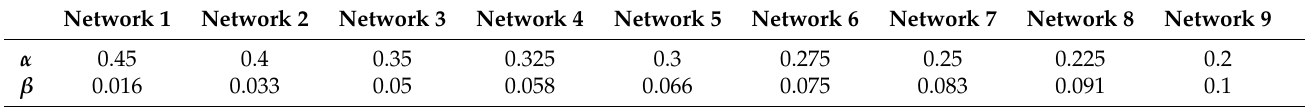
Table 1. Parameters used to generate the adjacency matrix A of each model.